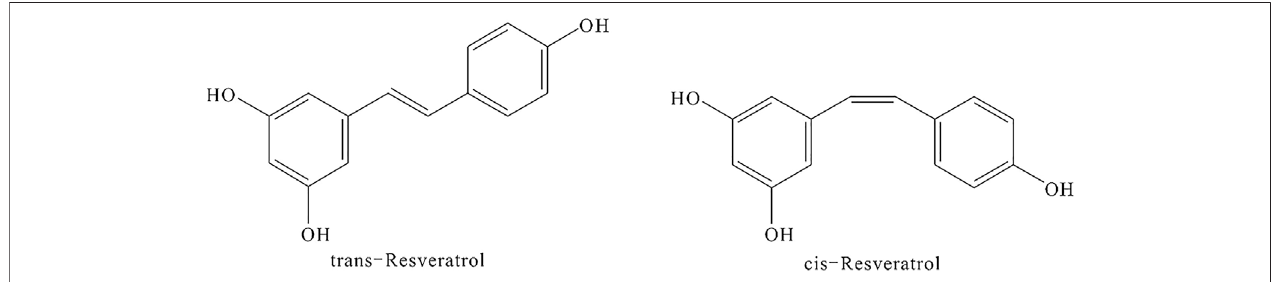
FIGURE 13 | The chemical structure of